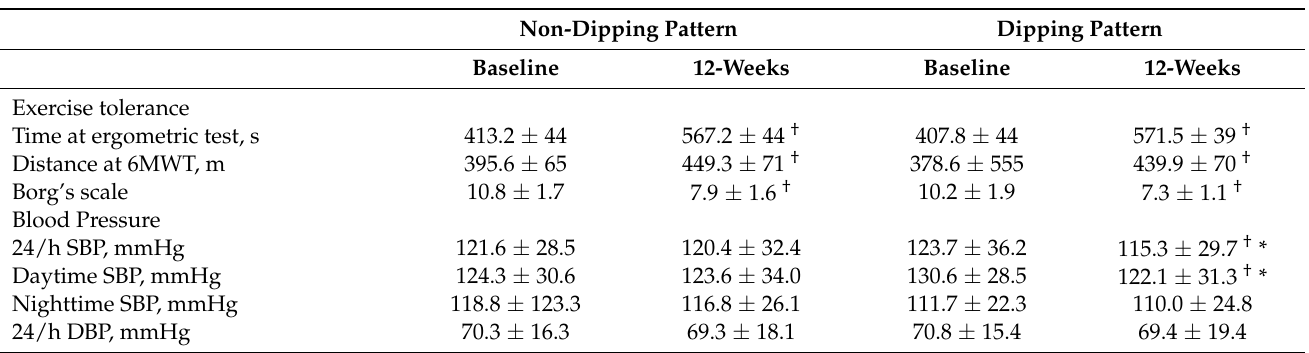
Table 2. Changes in blood pressure values and blood pressure variability after the 12-weeks of concurrent training in the dipping and non-dipping